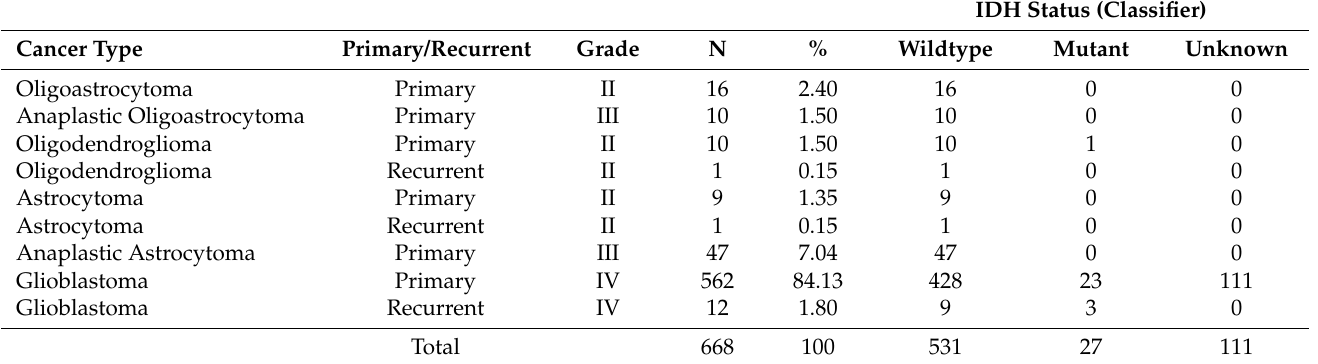
Table 1. Overview of the Grade II–IV gliomas (IDH-wildtype) analyzed in this study. The subtypes listed are from the 2016 WHO classification system used at the time of initial diagnosis recorded by TCGA. In this study, IDH status was determined using TCGA mutation data for IDH1/2. Also listed, for comparative purposes only, is the clinical information for IDH status determined using the TCGA classifier approach (see Supplementary Materials of Ceccarelli et al., 2016